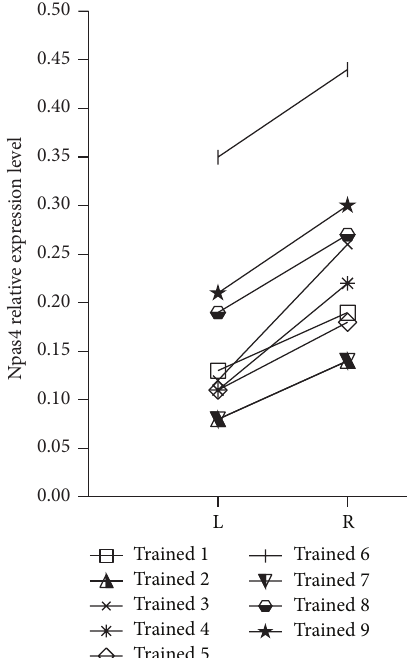
Figure 5: Changes of Npas4 mRNA expression in individual conditionedmice—comparisonbetweentrainedrowBofbarrels(R: right) and control row B (L: